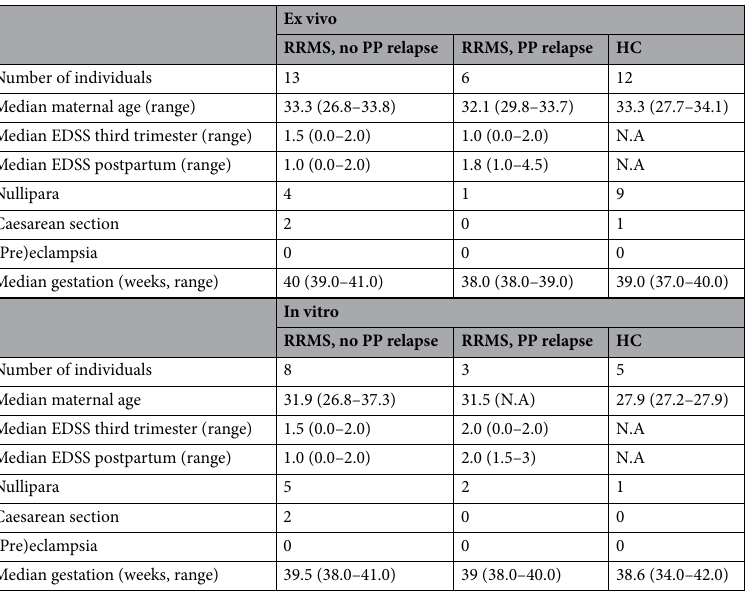
Table 1. Clinical information of pregnant MS patients and healthy controls. Information on cesarean section, nullipara, pre(eclampsia) and gestational period was missing for 1 RRMS patient with a PP relapse. PP